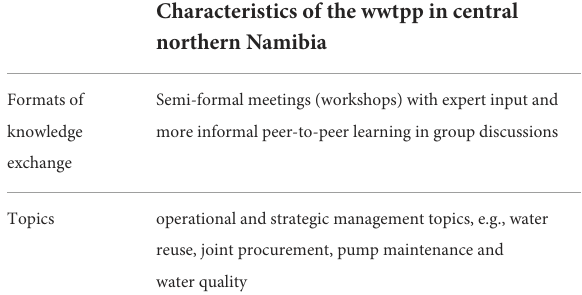
TABLE 1 Drivers, scopes and institutional structures of wwtpp. TABLE 2 Topics and formats of knowledge exchange.